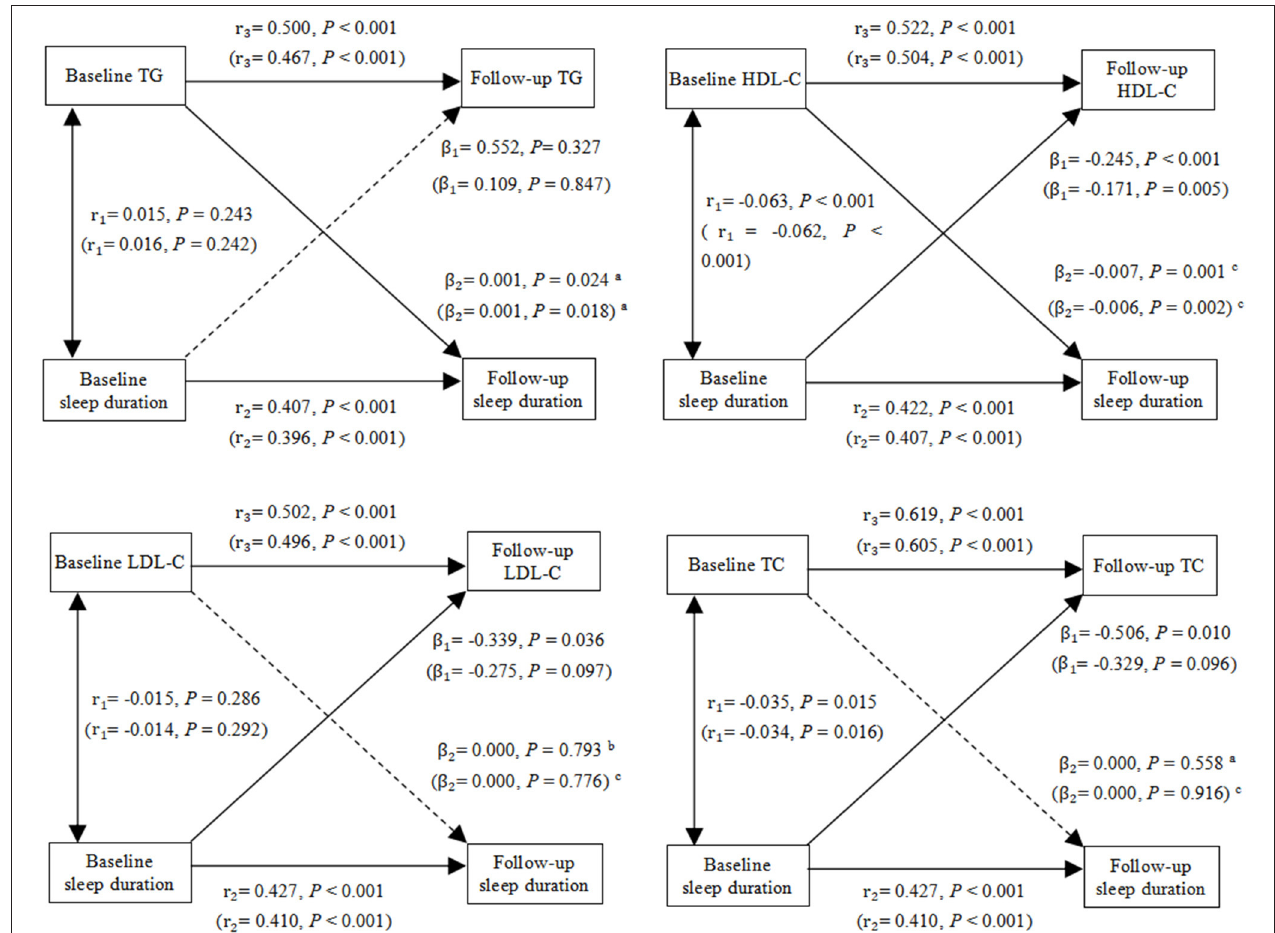
FIGURE 2 | Cross-lagged path analysis of TG, HDL-C, LDL-C, TC and sleep duration. The results outside brackets came from initial models, and the results in brackets came from adjusted models. Initial model was adjusted for no covariates. Adjusted model was adjusted for gender, BMI, age, smoking status, drinking status, region, marital status, education levels, medical insurance, systolic, diastolic, glucose and HbA1c. r 1 , synchronous correlation coefficients; r 2 and r 3 , stability paths coefficients; β 1 and β 2 , cross-lagged path coefficients. Goodness-of-fit (initial model/adjusted model): TG: CFI = 1.000/1.000, SRMR = 0.003/0.001, RMSEA = 0.000/0.014; HDL-C: CFI = 0.997/0.998, SRMR = 0.011/0.002, RMSEA = 0.047/0.038; LDL-C: CFI = 1.000/1.000, SRMR = 0.005/0.001, RMSEA = 0.017/0.004; TC: CFI = 0.999/1.000, SRMR = 0.006/0.001, RMSEA = 0.025/0.000. a P < 0.05 for the statistically significant difference between β 1 and β 2 . b 0.05 ≤ P ≤ 0.1 for the marginal statistically significant difference between β 1 and β 2 . c P > 0.1 for the non-statistically significant difference between β 1 and β 2